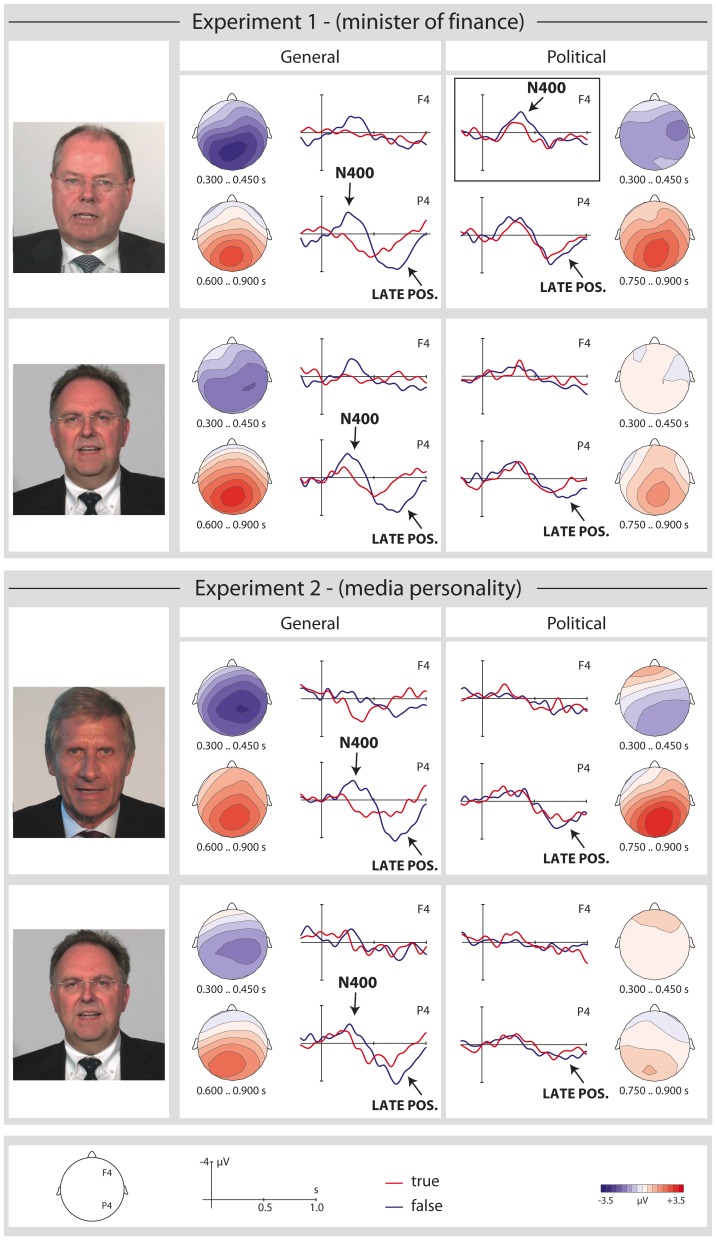
Grand average event-related brain potentials (ERPs) timelocked to the critical word (onset at the vertical bar) for general and political statements in Experiment 1 (top panel) and Experiment 2 (bottom panel).For each experiment, the higher panel shows the ERP responses for the high-profile speaker whereas the lower panel shows the ERP responses for the control speaker. ERPs are depicted for two selected electrodes, while the distribution of the N400 and late positivity effects is shown by the topographical maps (false – true). The frame in the top right-hand corner highlights the selective electrophysiological response for false political statements made by the finance minister. Negativity is plotted upwards. Speakers gave written informed consent to the publication of their photos in this figure.